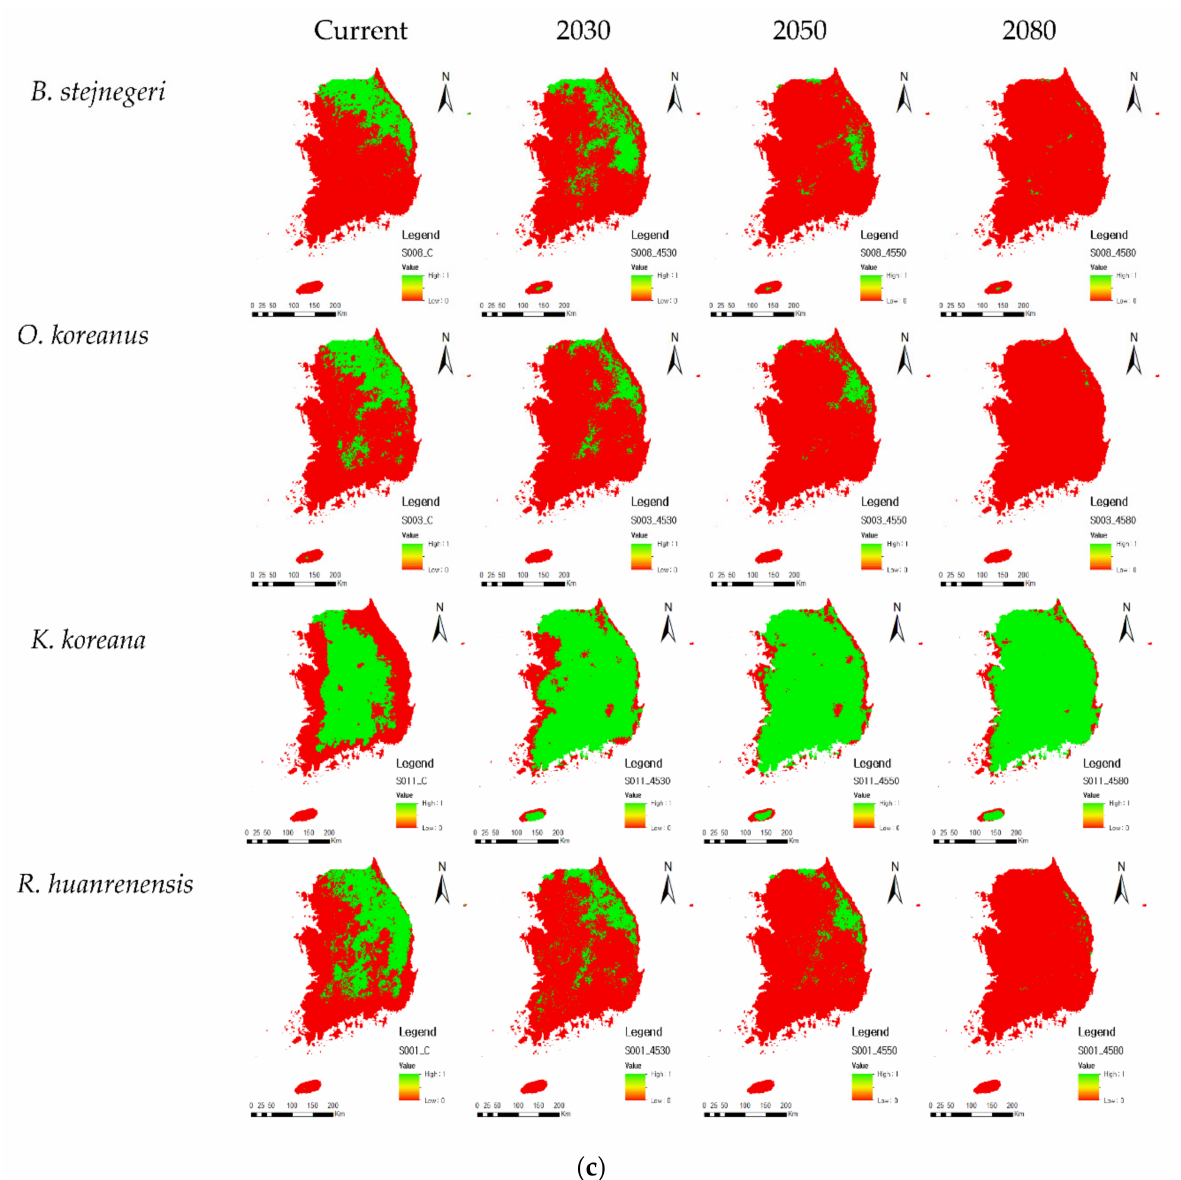
Figure A2. ( a ) Group 1. Wetland amphibians; ( b ) Group 2. Migrating amphibians; ( c ) Group 3. Forest dwelling